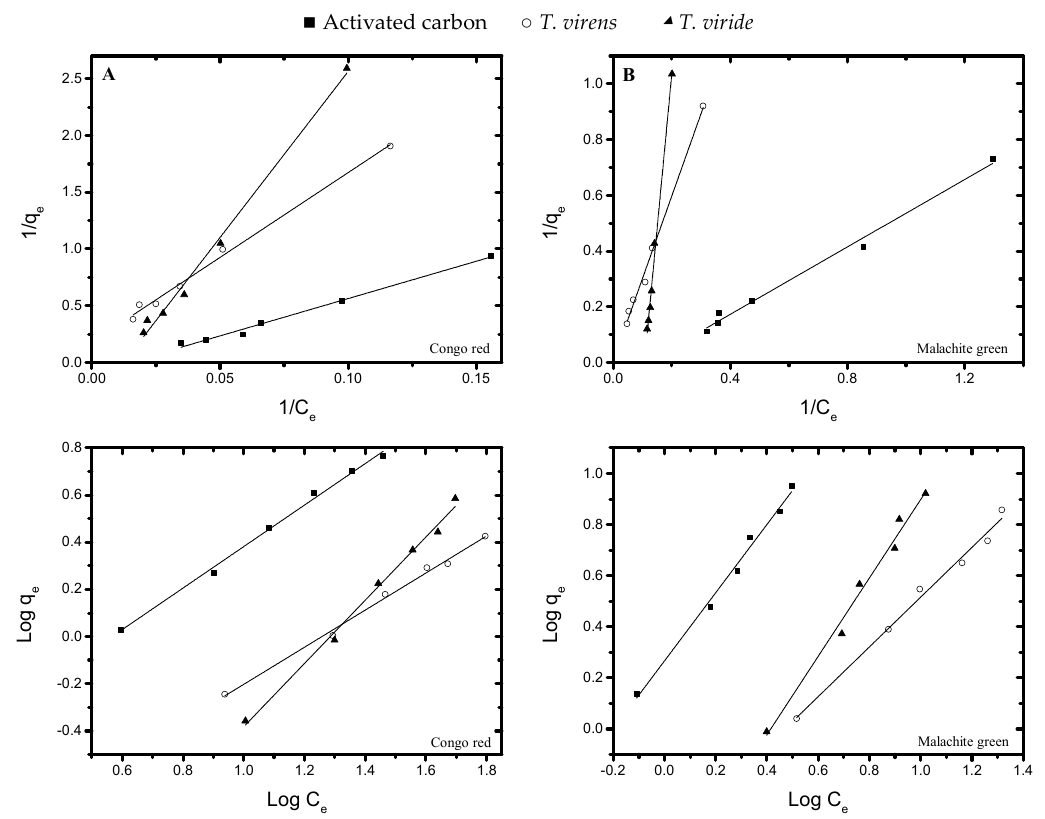
Figure 5. Linear Freundlich (Equation (2)) and Langmuir (Equation (3)) adsorption isotherm for Congo red (row A ) and malachite green (row B ).